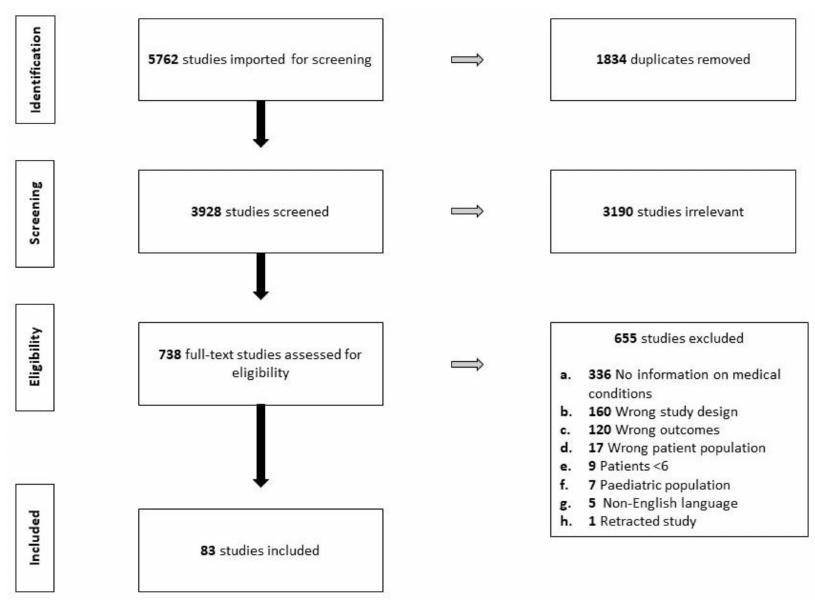
Figure 1. PRISMA flow chart.